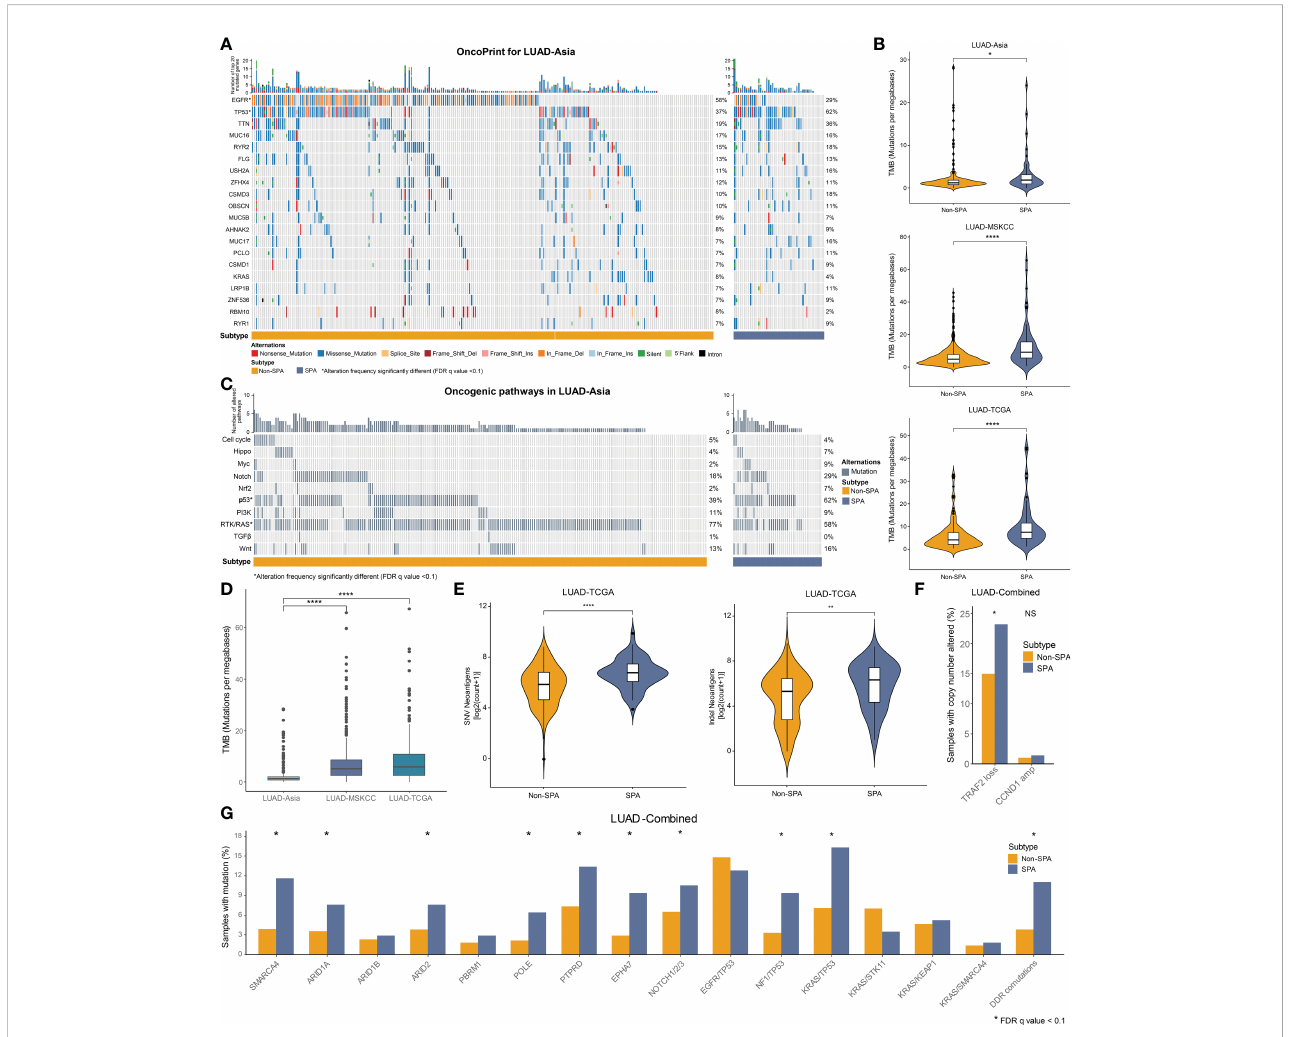
FIGURE 3 Mutational landscape of SPA and Non-SPA. (A) OncoPrint of the top 20 mutated genes in LUAD-Asia. *FDR q value < 0.1 (B) TMB of SPA and Non-SPA in the three cohorts. ****P < 0.0001, *P < 0.05 (C) OncoPrint of the 10 hallmark oncogenic pathways in LUAD-Asia. *FDR q value < 0.1 (D) Differences in TMB between races. ****P < 0.0001 (E) Comparison of neoantigen load between SPA and Non-SPA in LUAD-TCGA. ****P < 0.0001, **P < 0.01 (F) Comparison of TRAF2 loss and CCND1 ampli fi cation between SPA and Non-SPA in LUAD-Combined. *P < 0.05; NS, not signi fi cant (G) Frequency of gene alterations associated with response to immunotherapy and co-mutations in SPA as compared with Non-SPA in the combined cohort (LUAD- Combined). *FDR q value < 0.1. SPA, solid predominant adenocarcinoma; Non-SPA, non-solid predominant adenocarcinoma; TMB, tumor mutational burden; DDR, DNA damage